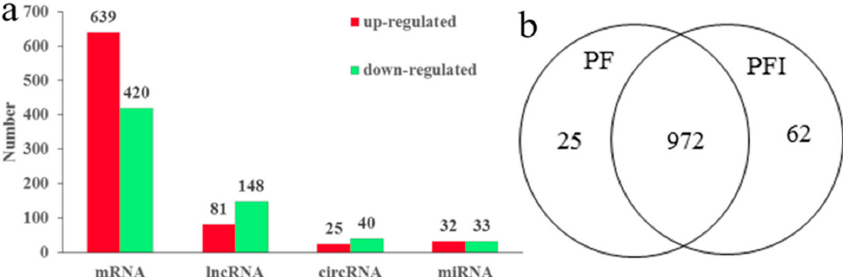
Figure 2. Expression analysis of microRNAs (miRNAs), Circular RNAs (circRNAs), long noncoding RNAs (lncRNAs), and mRNAs. ( a ) Differently expressed miRNA, mRNA, lncRNAs and circRNAs; ( b ) common and specific differentially expressed genes (DEGs) in PF and PFI.